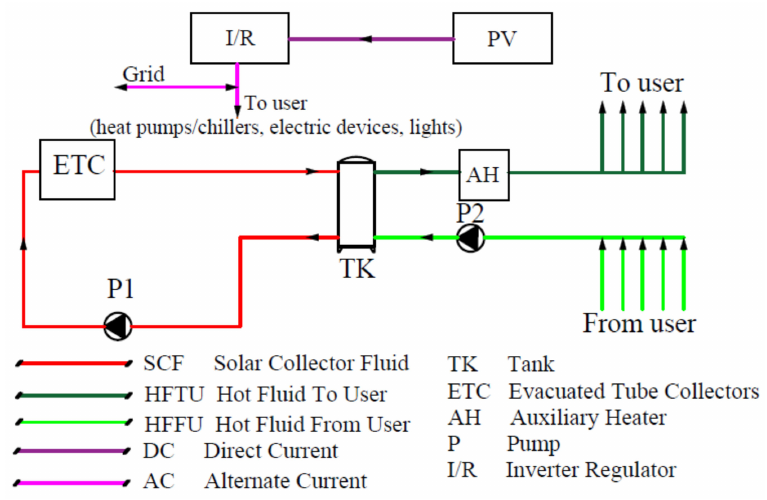
Figure 1. Proposed system layout for the districts in Italy and